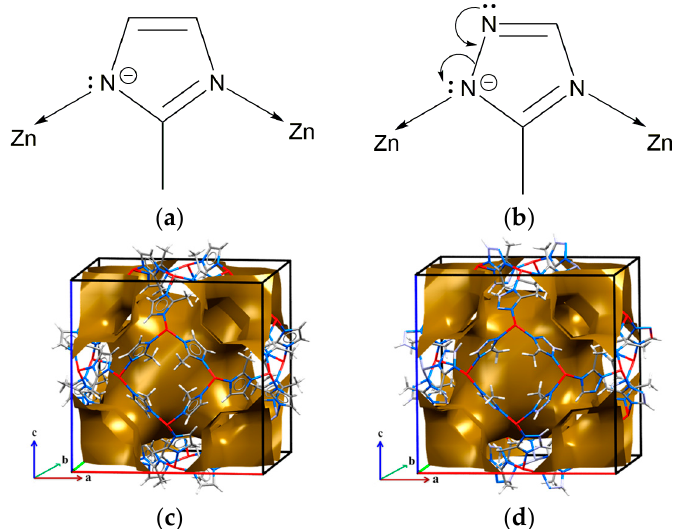
Figure 1. Crystal structures of ZIF-8 and MAF-7. Coordination modes of ( a ) imidazolate and ( b ) 1,2,4-triazolate; framework structures of ( c ) ZIF-8 and ( d ) MAF-7. The electron-donating effect is indicated by arrows. The yellow surfaces indicate the solvent accessible voids of ZIF-8 and MAF-7 which are 49.8% and 51.7%, respectively [16]. Color codes used: zinc, red; carbon, grey; nitrogen, blue; hydrogen, white.